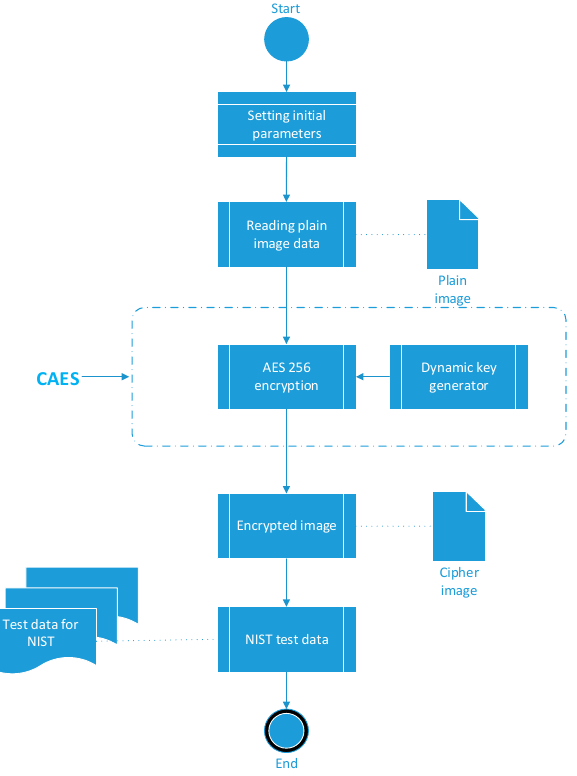
Figure 8. Flow chart of encryption using chaos-based AES (CAES).